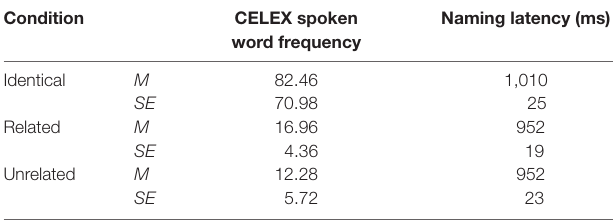
TABLE 1 | Psycholinguistic properties of picture stimuli. Condition